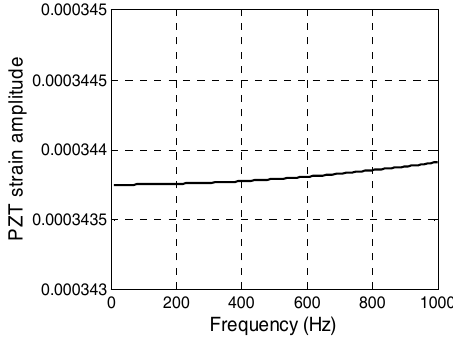
Figure 5. Frequency-PZT strain amplitude curve (0 Hz–1 kHz).